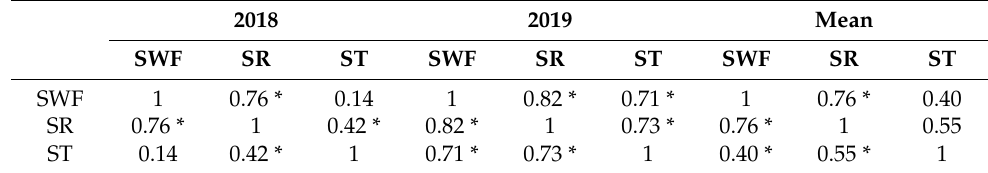
Table 1. Pearson coefficient of correlation between soil water flux (SWF), soil respiration (SR), and soil temperature (ST).